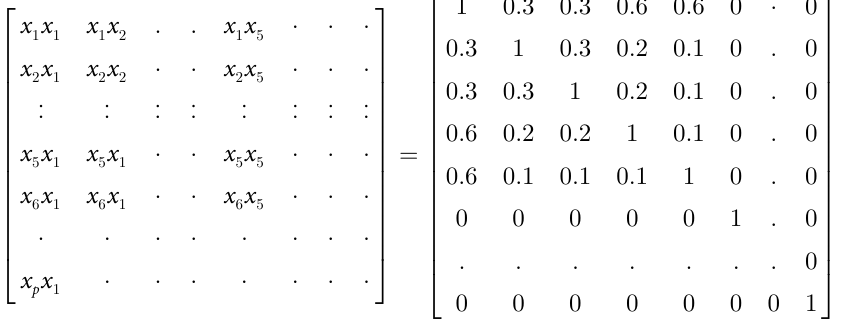
The data for each feature is generated from the multivariate normal distribution. Table 1 shows the different settings considered for evaluating the different models. The number of fea- tures, p , considered across different settings varied from 25–100. The training and test dataset used in each scenario is 500. Scenario 4 does not consider the marginal effect of the interaction terms. The number of target variables is put less than n to enable comparison with standard methods.